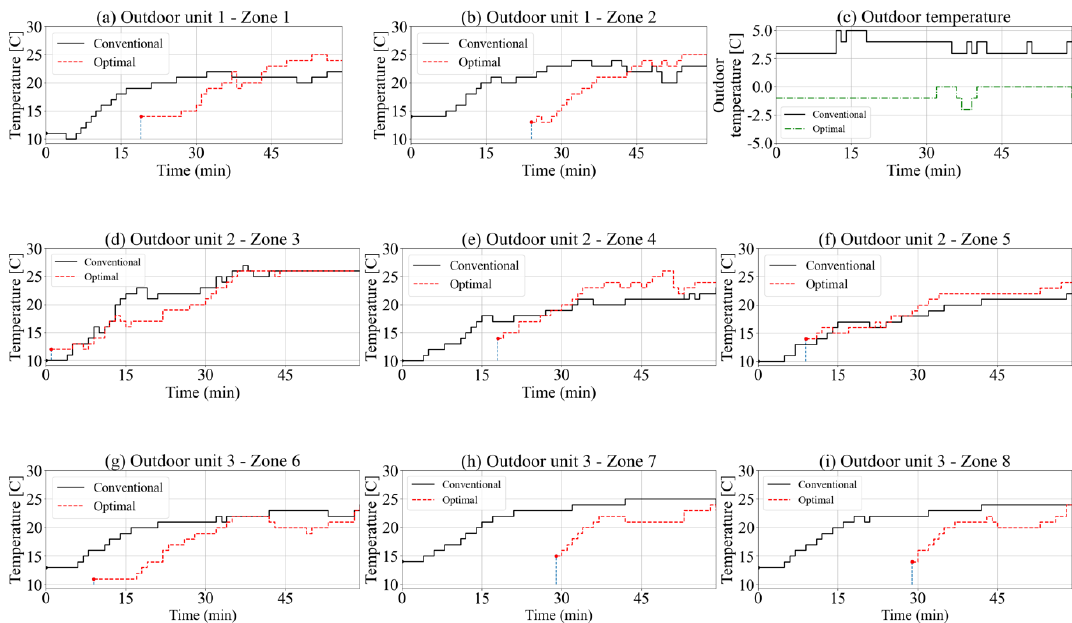
Figure 6. Comparison of the optimal control effect by indoor and outdoor units (day 4): ( a , b ) outdoor unit 1, ( c ) outdoor temperature, ( d – f ) outdoor unit 2, ( g – i ) outdoor unit 3.